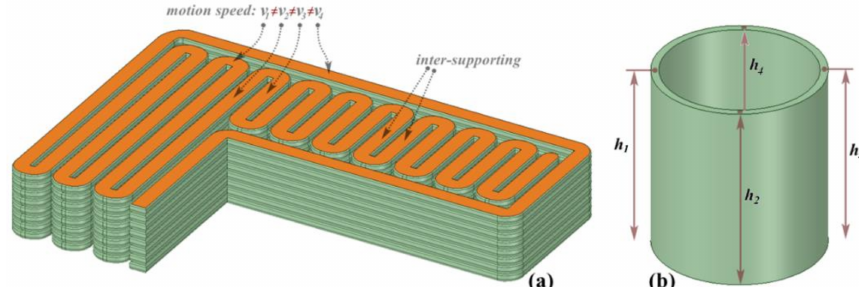
Figure 4. ( a ) Illustration of inter-support from adjacent filaments and variable motion speeds and ( b ) method for determining whether the printed result is a Pass or